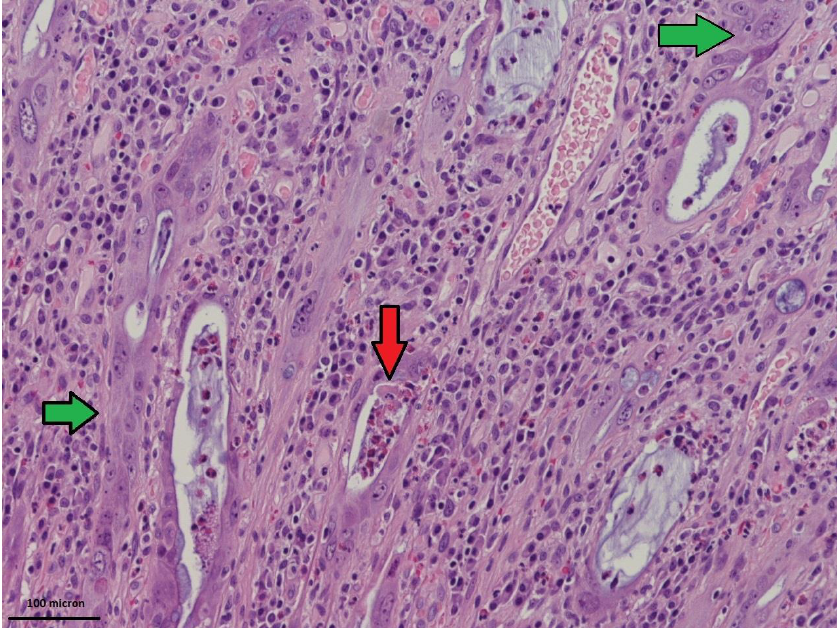
Figure 2. High power view of radiation-damaged non-neoplastic mucosa in PSRT sample: Distorted glands lined by atypical epithelium (green arrows) and eosinophils aggregates (red arrow) within glandular epithelium (Hematoxylin and Eosin (HE) 200 times magnified). Scale Bar: 100 microns.